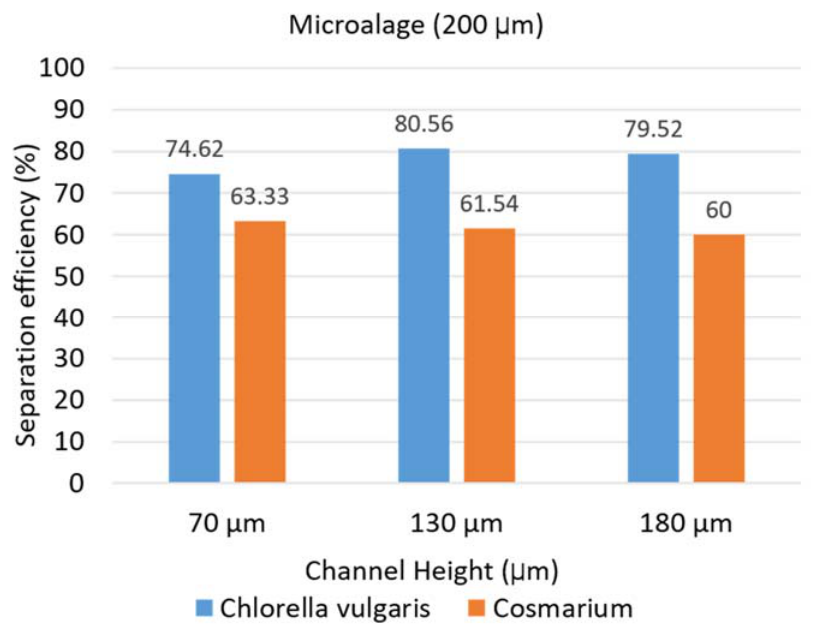
Figure 10. The separation efficiency of microalgae in a spiral channel of width 200 µm, between three channel heights—70, 130, and 180 µm.